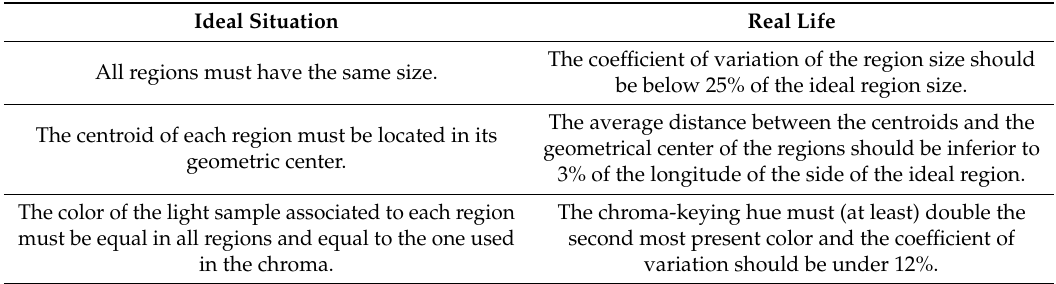
Table 1. Results of the calibration process in an ideal situation (left) and requirements for the results of the calibration process in a real-life environment to be acceptable for a good chroma-keying quality. Ideal Situation Real Life The coe ffi cient of variation of the region size should All regions must have the same size. be below 25% of the ideal region size. The average distance between the centroids and the geometrical center of the regions should be inferior to geometric center. 3% of the longitude of the side of the ideal region. The chroma-keying hue must (at least) double the second most present color and the coe ffi cient of variation should be under